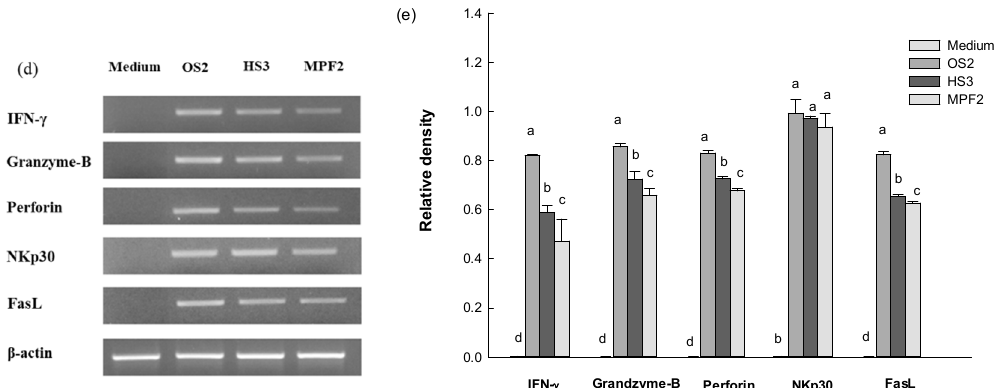
Figure 7. Effect of MPF2 and derivatives on NK cell activities: ( a ) cell proliferation and ( b ) cytotoxicity against HepG2 cells, ( c ) percentage improvement on NK cell cytotoxicity, ( d ) mRNA expression in NK cells, and ( e ) relative band intensity. Different letters indicate significant differences ( p < 0.05) between MPF2 and its derivatives at each cytokine.